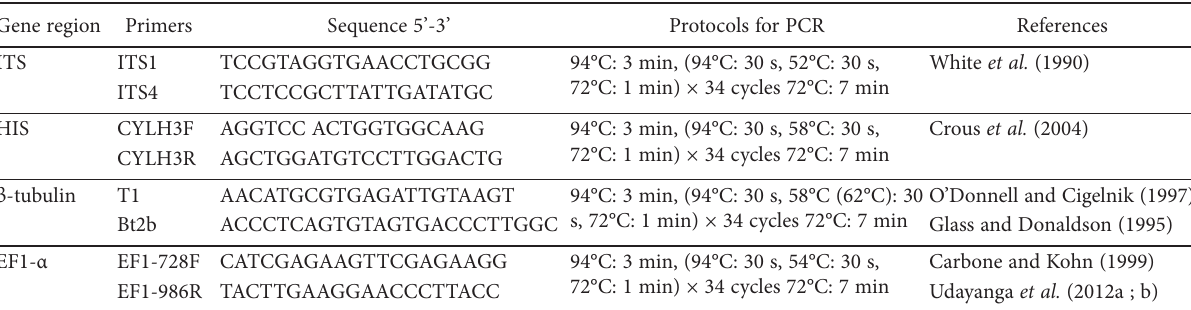
Table 1. The primer pairs and their amplified protocols used in present